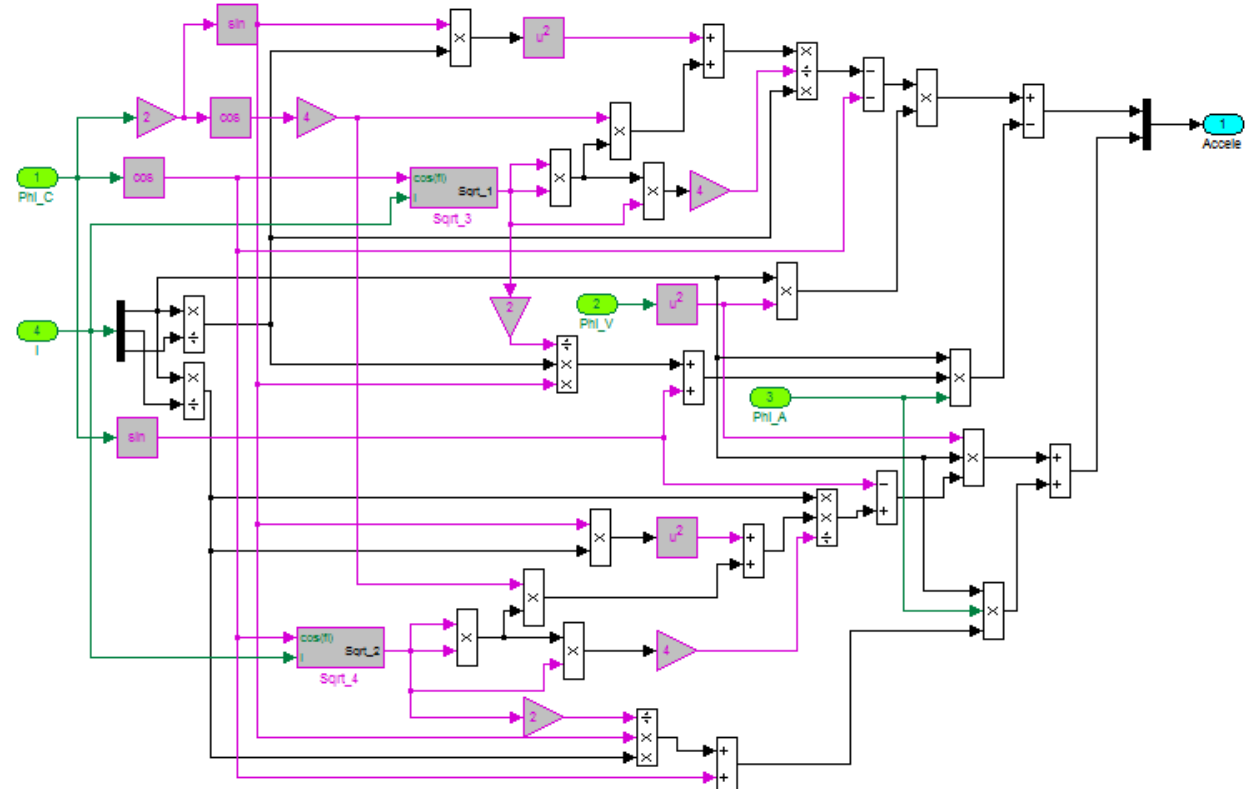
Figure 9. Determination of projection of point C acceleration (calculation using Eqs. 4 and